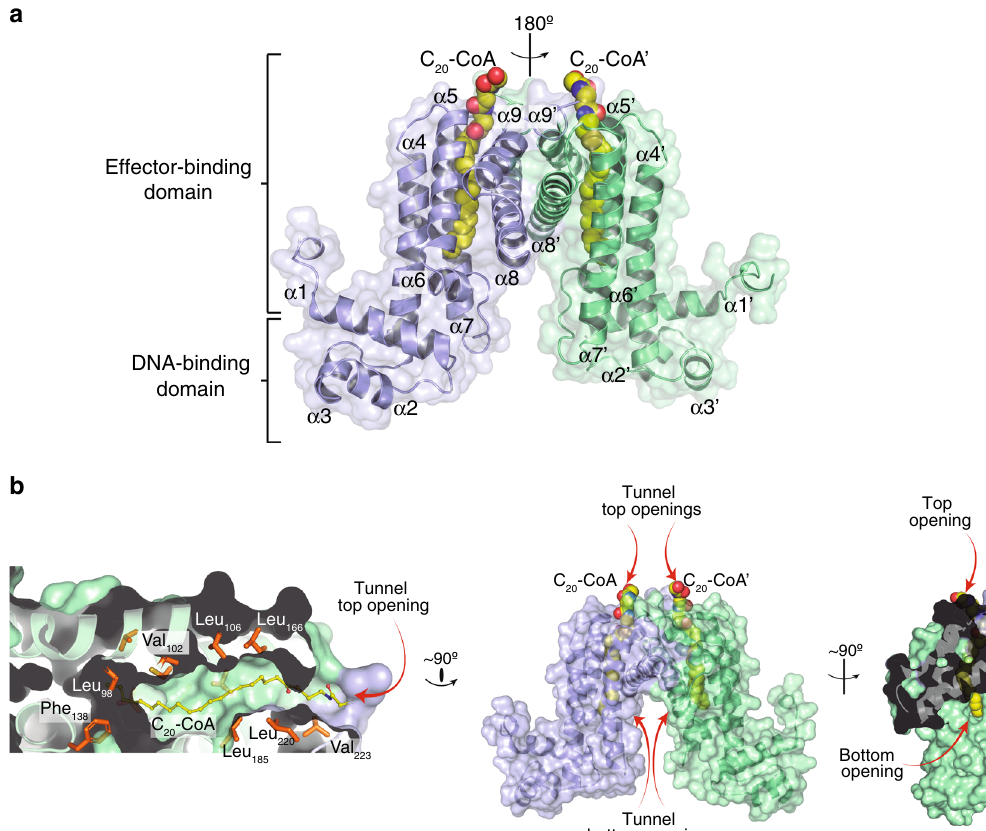
Fig. 1 Crystal structure of FasR Δ 33 -C 20 -CoA. a FasR dimer in cartoon representation, the two protomers are distinguished in light blue and pale green. The dimer is strictly symmetric, with one protomer in the asymmetric unit, the crystallographic twofold is depicted as a vertical axis in the plane of the fi gure. Secondary structure elements are labelled; a prime symbol denotes equivalent elements in the other protomer. The two domains are indicated, an N- terminal DNA-binding domain with a helix – turn-helix (HTH) motif, and a C-terminal domain with the co-crystallised effector molecule C 20 -CoA bound (in spheres coloured by element). b Details of the effector-binding tunnel. Three orthogonal views illustrate the molecular surface of FasR Δ 33 .The leftmost cuts along the middle of a protomer, revealing the top tunnel mouth on the right and a large segment of the tunnel itself with the bound acyl moiety (in sticks). A few amino acid side chains that de fi ne the tunnel walls are labelled. The rightmost panel is an open-book perspective, with the footprint of protomer A visible on protomer B ’ s surface (in pale green), the two openings of the tunnel are visible, showing solvent exposure of both tips of the C 20 -CoA